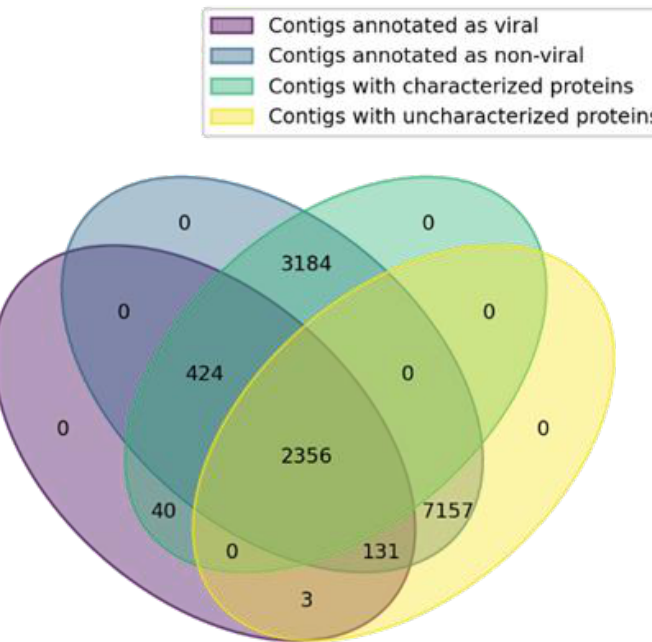
Figure 5. Venn diagram illustrating the distribution of contigs into groups: viral/non-viral and with known/unknown proteins. The number of contigs with “unknown” proteins among non-viral contigs exceeds the number among viral contigs.